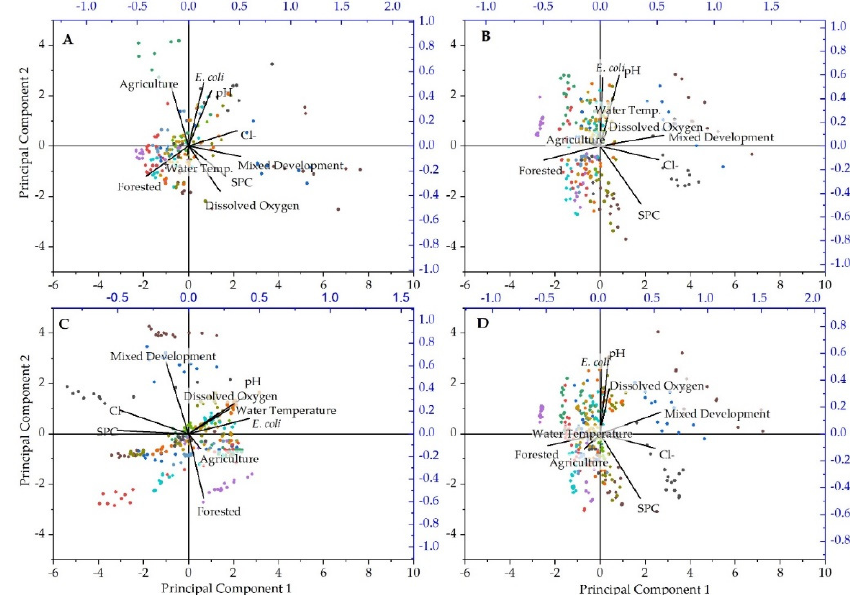
Figure 10. Results of principal components analysis, including biplots, for extracted principal components of quarterly E. coli concentration (CFU per 100mL), water temperature (°C), pH, specific conductance (µS/cm), dissolved oxygen (%) and chloride ion (mg/L) at 22 monitoring sites (indicated